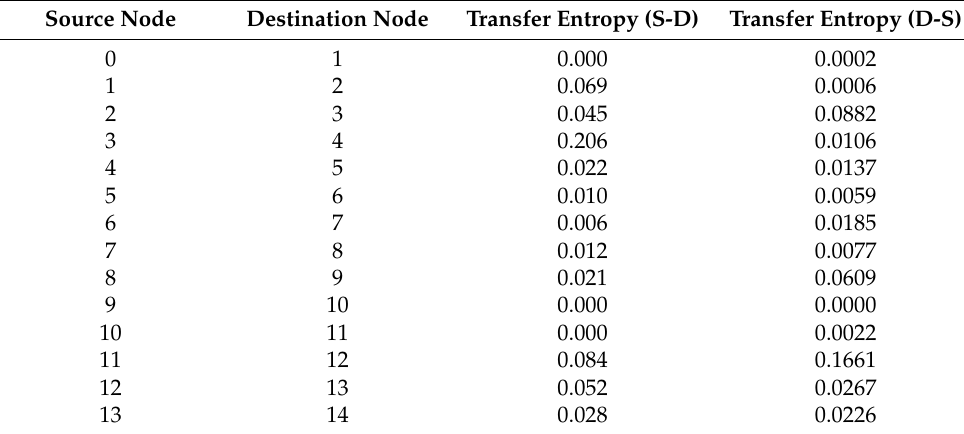
Table 6. TE values calculated based on node degrees from Table 5.